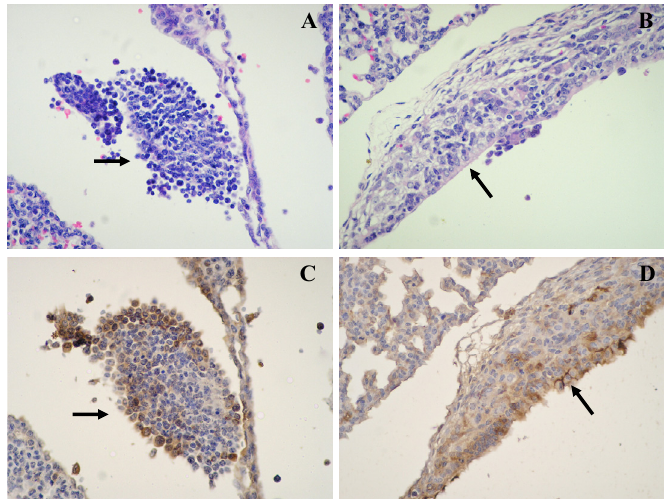
FIGURE 2 - Photomicrograph of histological sections of the fetal trunks with heterotopic brain tissue (arrows) stained with Hematoxylin and Eosin and submitted to immunohistochemical reaction with Bcl2 antibody. A and C are from E18 group, whereas B and D are from P8 group, both with fragments over the visceral pleura (arrow). (A and B: Hematoxylin and eosin staining; C and D: Immunohistochemical reaction using the SuperPicTure Polymer Detecetion Kit method with the primary Bcl2 antibody; developed with DAB, 400X original magnification)